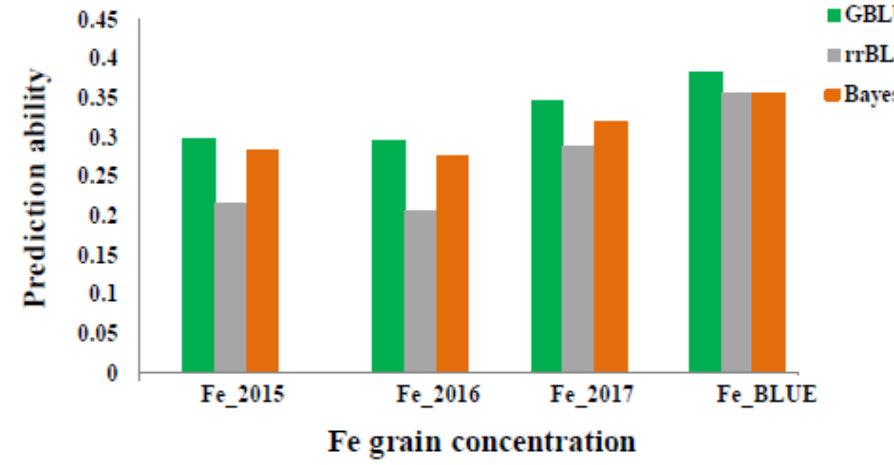
Figure 6. Prediction ability values for grain Fe concentration ( µ g · g − 1 ) according to different years (2015, 2016 and 2017) and BLUEs by using three different statistical models: GBLUP, rrBLUP and BayesC.